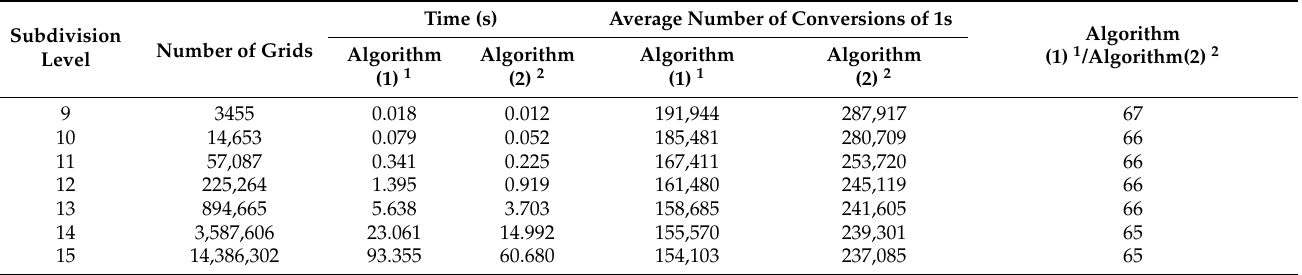
1 Resampling conversion algorithm. 2 Row–column conversion algorithm. Table 11. Comparison table of the algorithms efficiency of conversion from TRQ encoding to Good- child